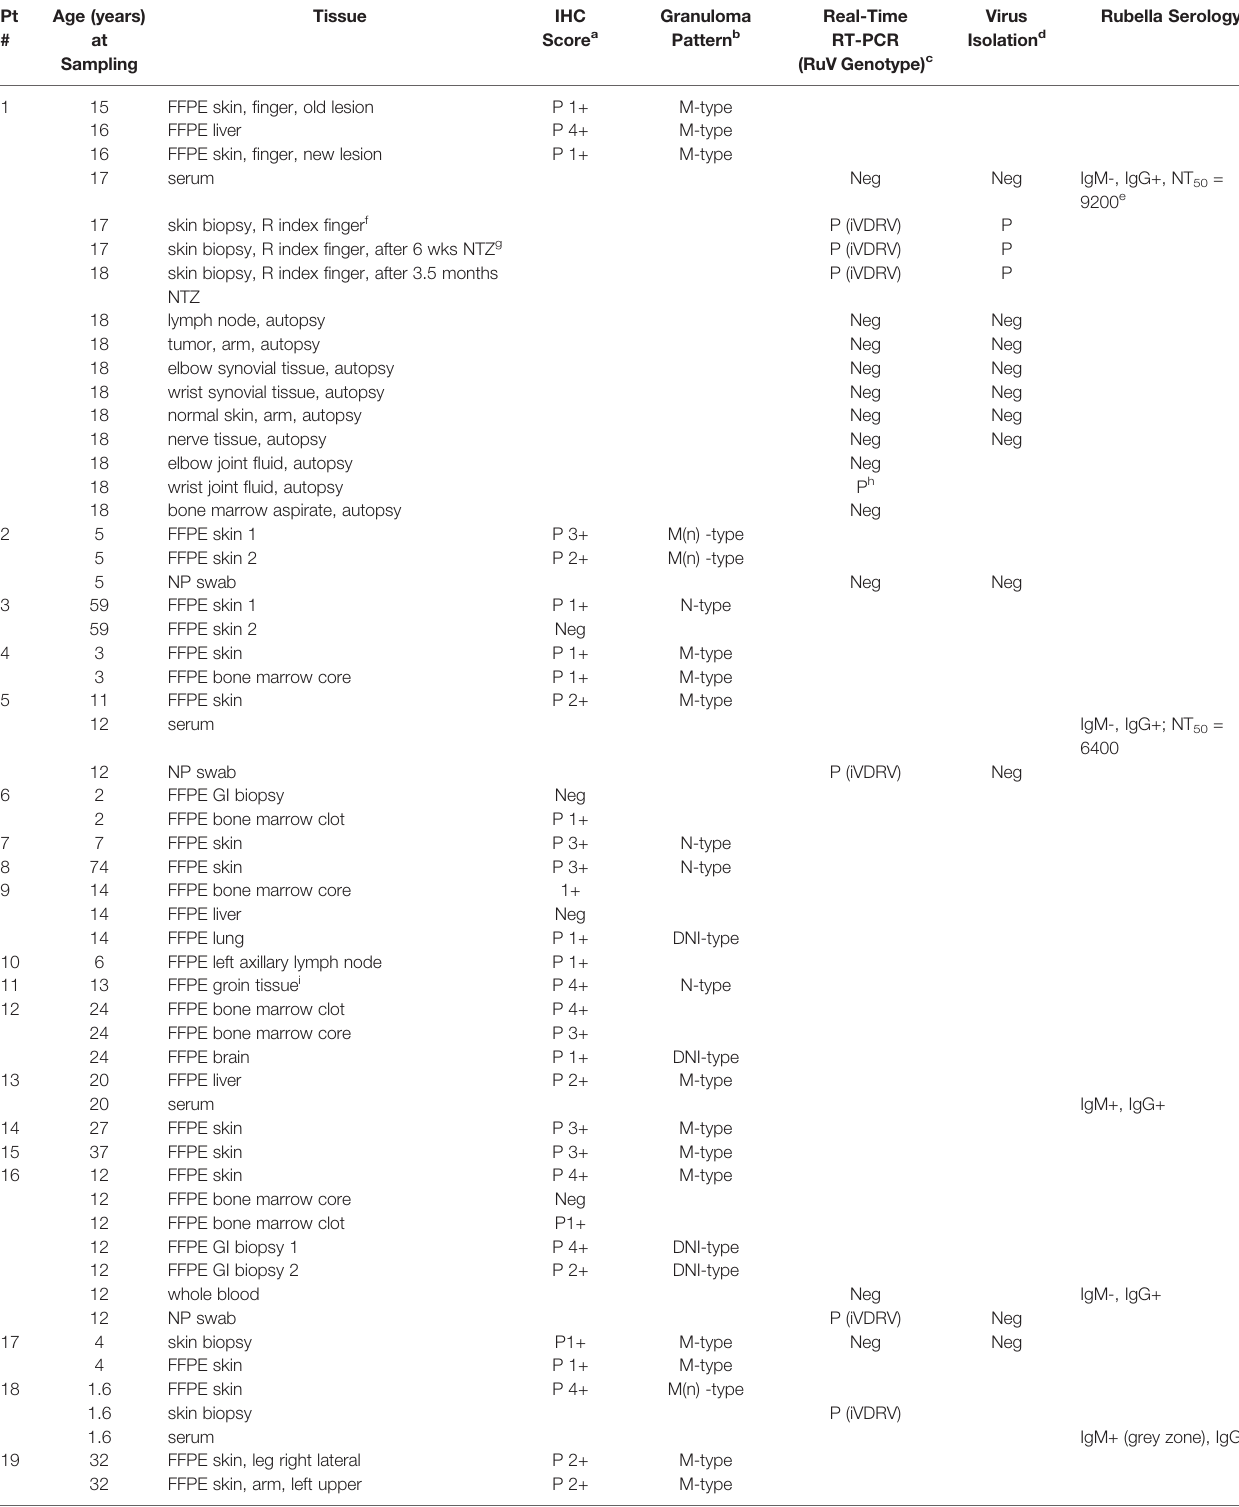
TABLE 1 | Rubella virus testing of clinical samples from 28 IEI